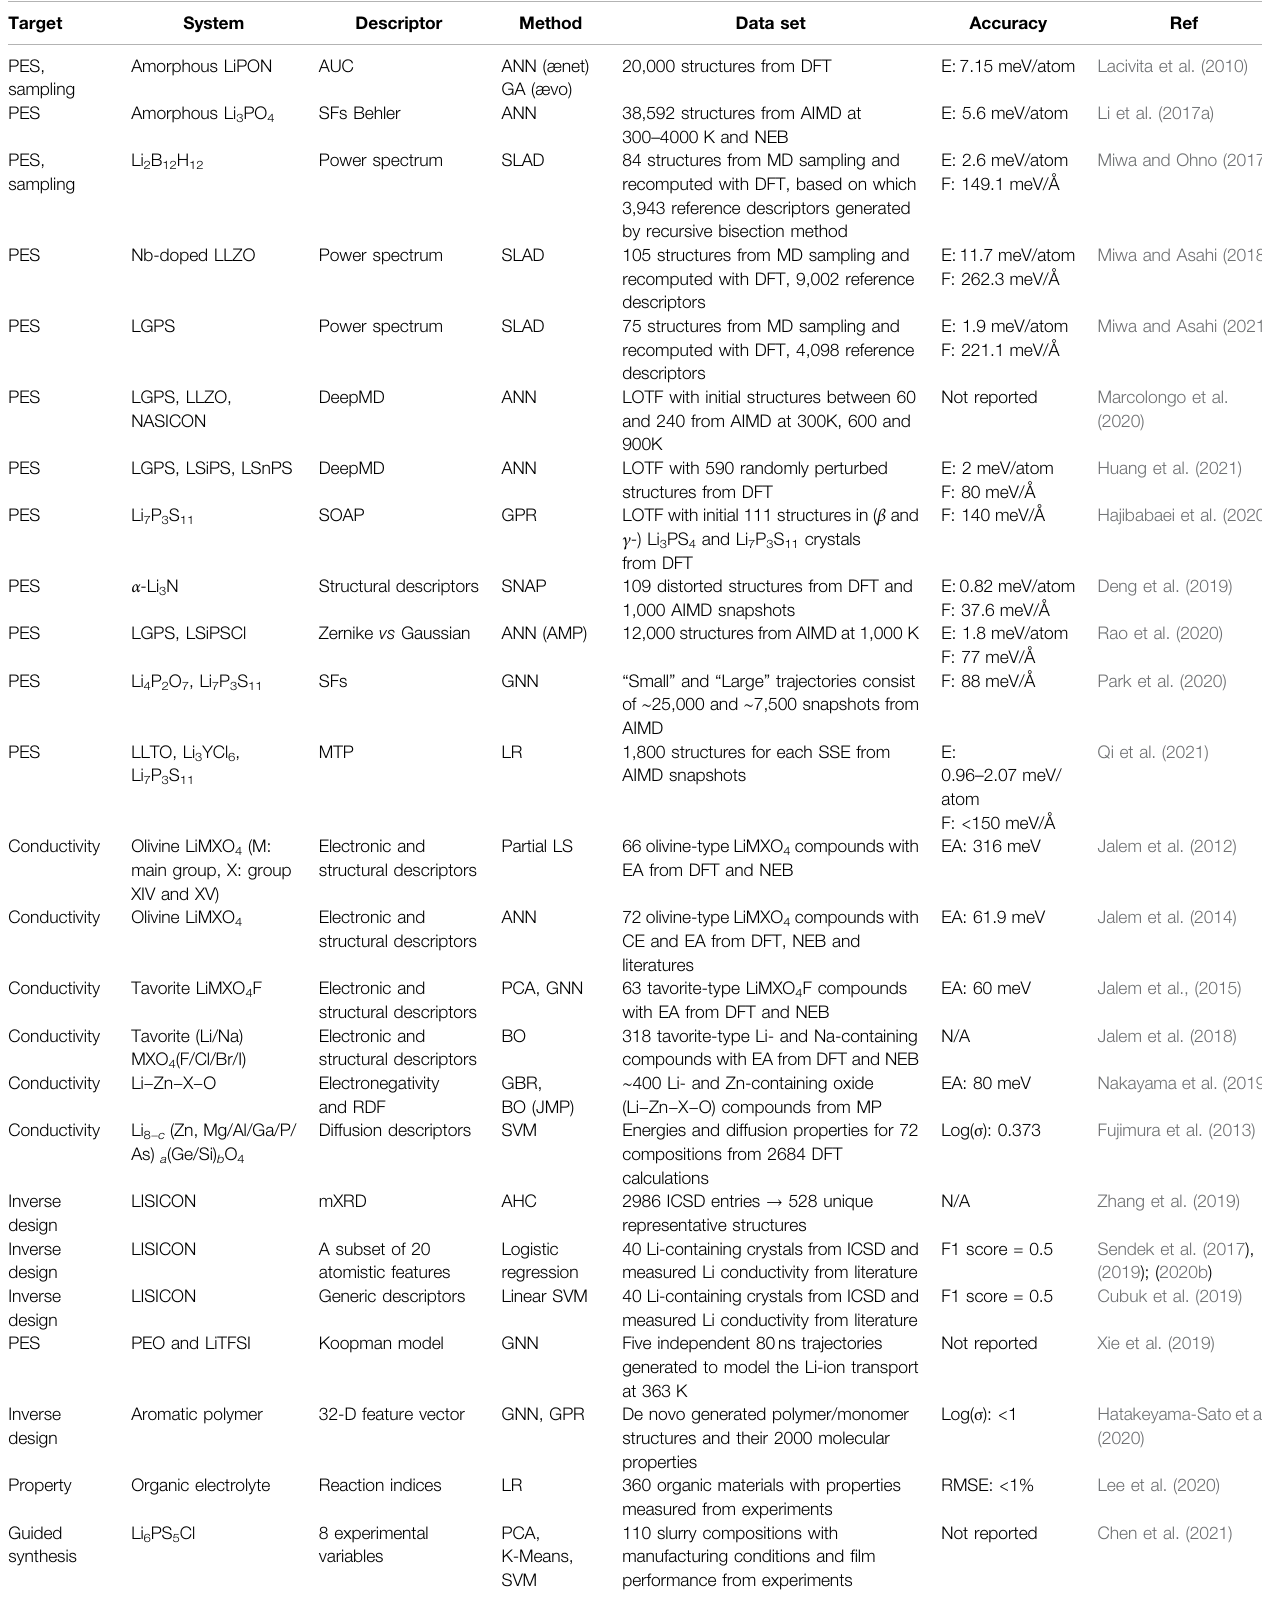
TABLE 3 | Summary of ML applications in solid-state electrolytes